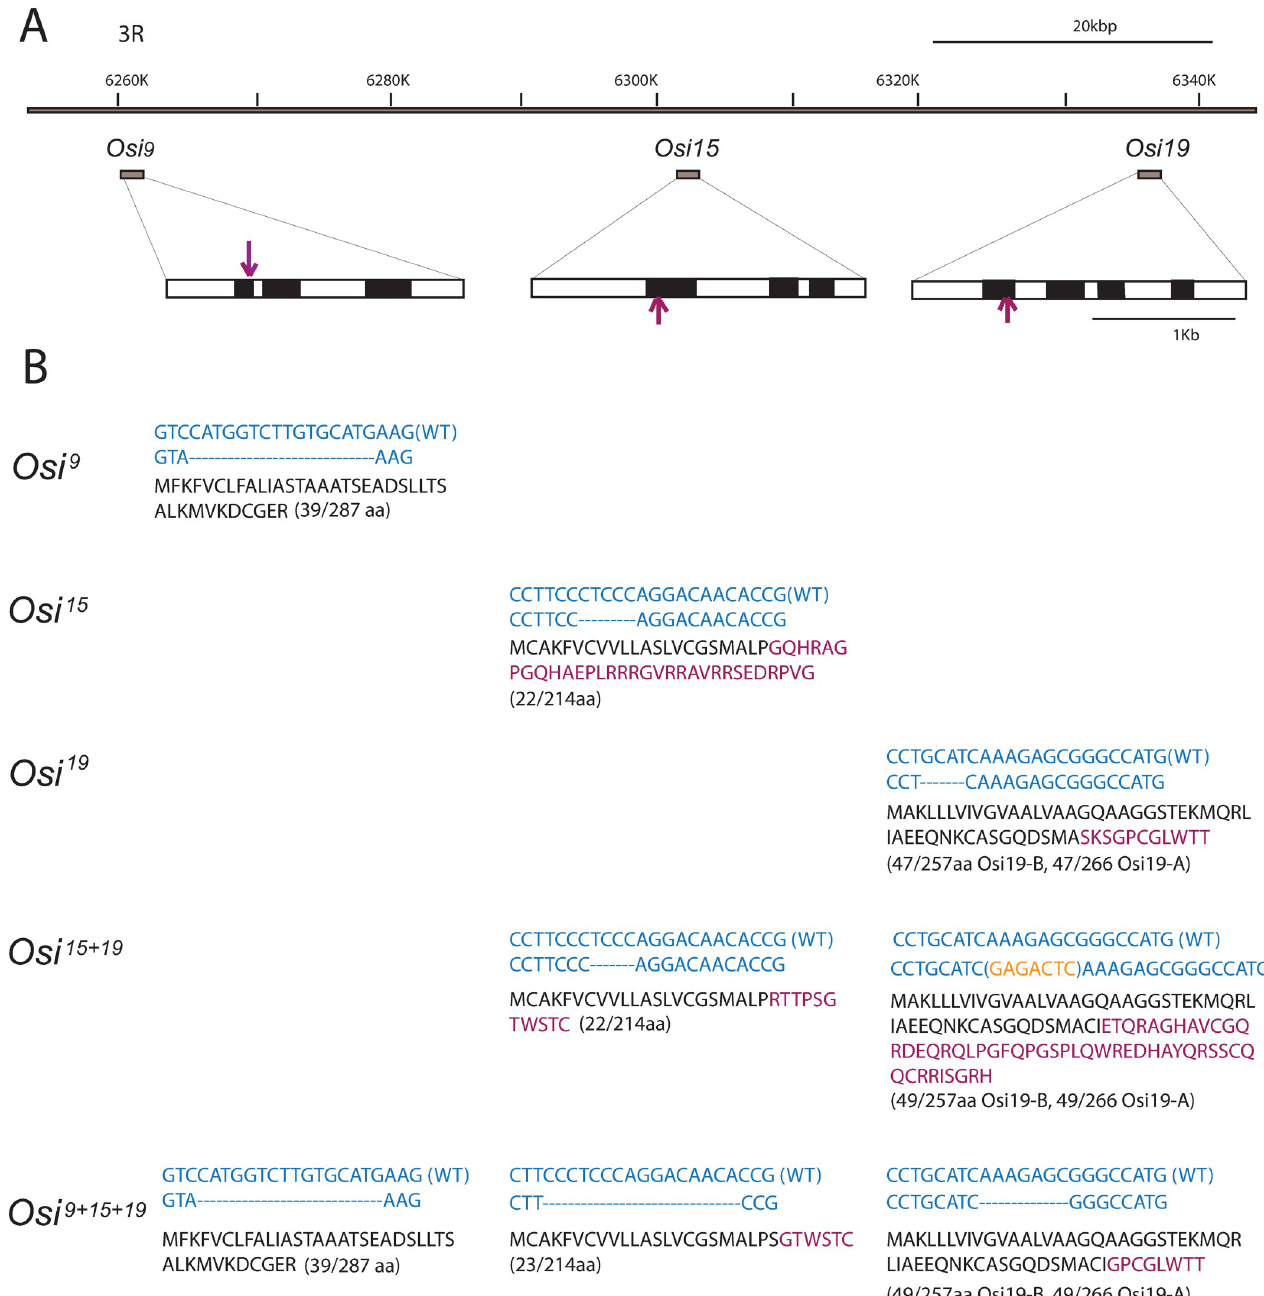
Fig 3. Generation of Osi loss of function mutants. Osi loss of function mutants were generated by CRISPR-Cas9. Single mutants Osi 9 , Osi 15 , and Osi 19 , double mutants Osi 15+19 , and triple mutants Osi 9+15+19 were shown. The genomic locus for Osi9 , Osi15, and Osi19 were displayed in (A) including intron (white box) and exon regions (black box). The CRISPR target site selected for each was indicated by a purple arrow. (B) Osi 9 , Osi 15 , Osi 19 , Osi 15+19 , and Osi 9+15+19 mutants were described with blue text representing the genomic sequence and black text representing the translated protein sequence. The partial sequence near the target site for each wild-type (WT) Osi gene was listed as the top line of blue text, while the mutant sequence was listed as the bottom line of blue text. In the CRISPR-modified genomic sequences, "-" represented deleted bases and yellow text in parentheses represented inserted bases. The translated protein sequences of the mutants were listed in black and purple text beneath the genomic sequences. The black text represented amino acids that match wild-type protein sequences, while purple amino acids were the result of frameshifts introduced during CRISPR genome editing. Following each amino acid sequence, the intact amino acids in the mutant sequences were compared to the original number of amino acids in the respective Osi proteins.